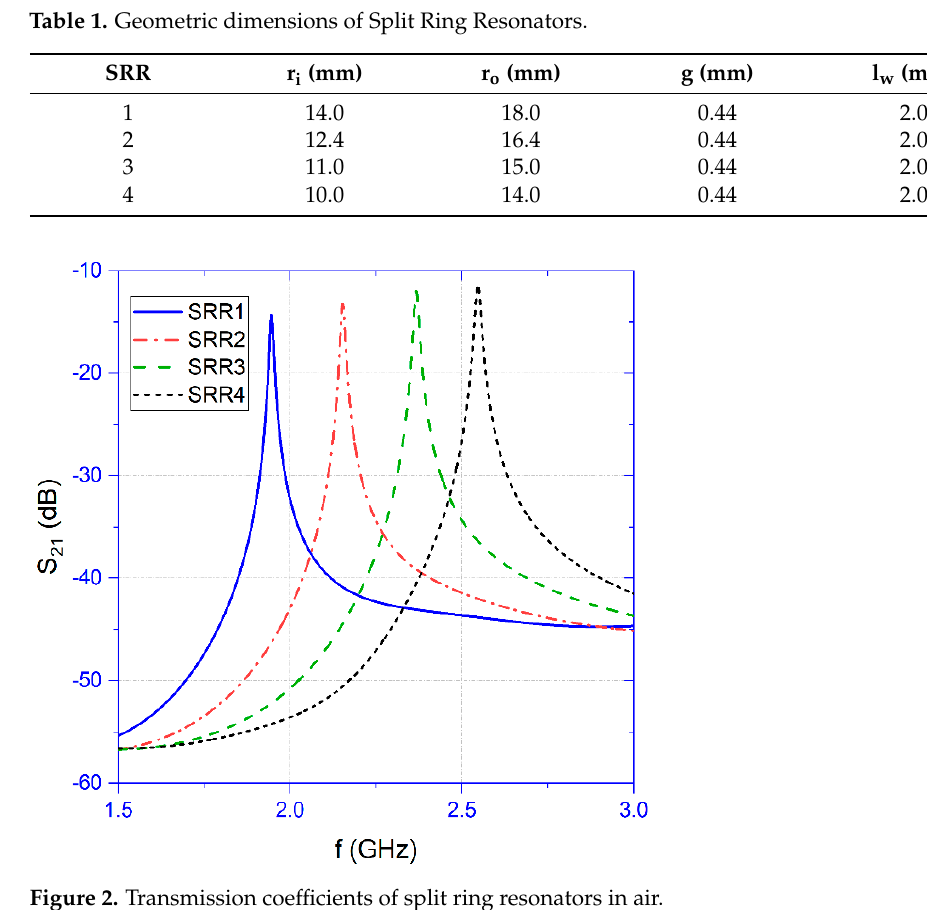
Figure 2. Transmission coefficients of split ring resonators in air. Table 1. Geometric dimensions of Split Ring Resonators.